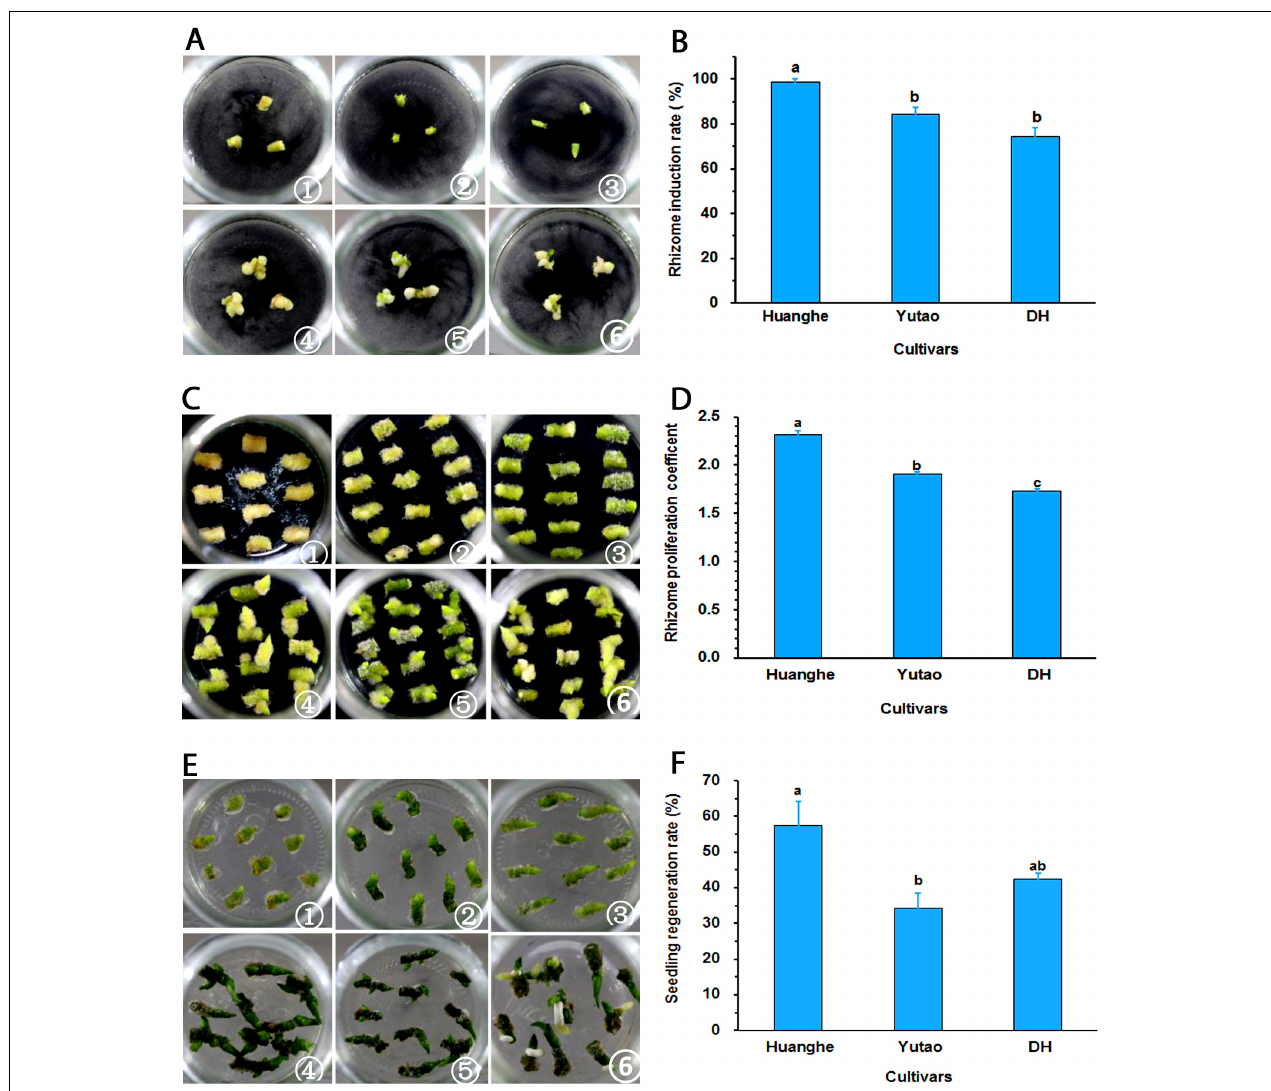
FIGURE 5 | Regeneration ability of polyploid Cymbidium cultivars developed from sexual polyploidization. (A) Induction of rhizomes from shoot tips: (cid:172) Shoot tip of “Huanghe” on day one; (cid:173) Shoot tip of “Yutao” on day one; (cid:174) Shoot tip of “DH” on day one; (cid:175) Shoot tip of “Huanghe” on day 40; (cid:176) . Shoot tip of “Yutao” on day 40; (cid:177) Shoot tip of “DH” on day 40. (B) Rhizome induction frequencies (%) of the three cultivars. (C) Rhizome proliferation: (cid:172) Rhizomes of “Huanghe” on day one; (cid:173) Rhizomes of “Yutao” on day one; (cid:174) Rhizomes of “DH” on day one; (cid:175) Rhizomes of “Huanghe” on day 40; (cid:176) Rhizomes of “Yutao” on day 40; (cid:177) Rhizomes of “DH” on day 40. (D) Rhizome proliferation coefficient of three cultivars. (E) Shoot regeneration from rhizomes: (cid:172) Shoot induction of “Huanghe” on day one; (cid:173) shoot induction of “Yutao” on day one; (cid:174) shoot induction of “DH” on day one; (cid:175) Shoot induction of “Huanghe” on day 40; (cid:176) Shoot induction of “Yutao” on day 40; (cid:177) Shoot induction of “DH” on day 40. (F) Shoot production rate of three cultivars from cultured rhizomes. Bars represent standard error, and different letters on the top of bars indicate significant cultivar difference for individual traits analyzed by Duncan’s multiple range test at P < 0.05